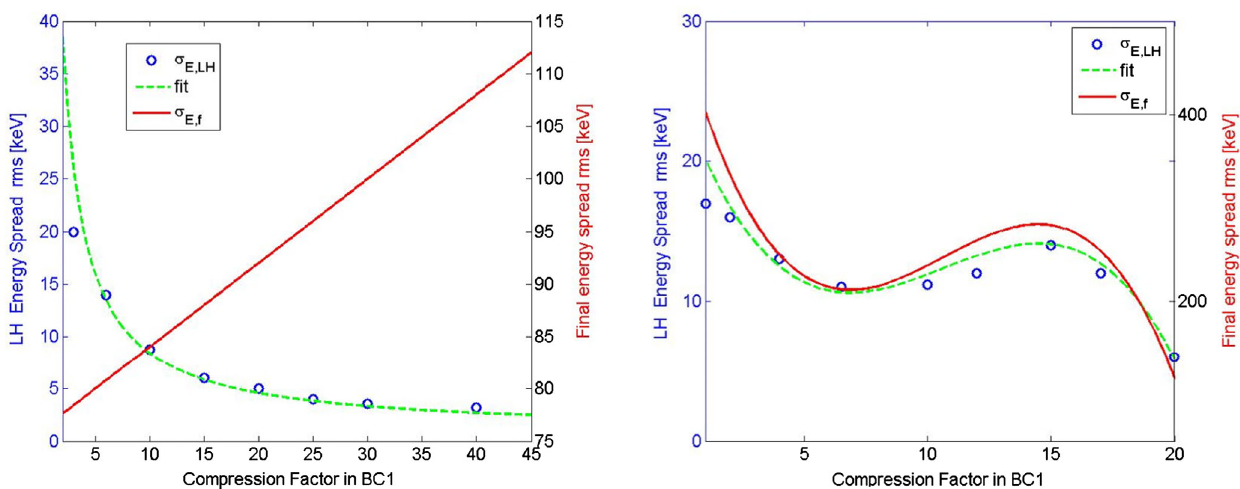
FIG. 4. Laser heater induced rms energy spread and final rms energy spread as a function of the first stage compression factor, for a 500 pC charge, 2.8 ps rms long bunch compressed in one stage (left) and two stages. In the latter, the total compression factor is fixed at 20. Data were evaluated with the analytical model of the MBI given in Refs. [12,13]. The energy spread is always meant to be slice. The final energy spread is the energy spread of the heated beam times the total compression